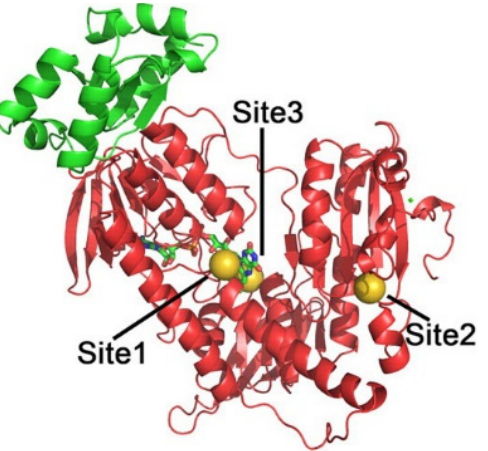
Figure 4. A three-dimensional model of one subunit of Schistosoma mansoni thioredoxin-glutathione reductase, SmTGR, is shown with the three gold-binding sites. The glutaredoxin domain of TGR is represented in green, whereas the thioredoxin domain is shown in red, and the bound flavin is also highlighted. (Reprinted with permission from ref. [46] Copyright © 2009 Elsevier Inc.).